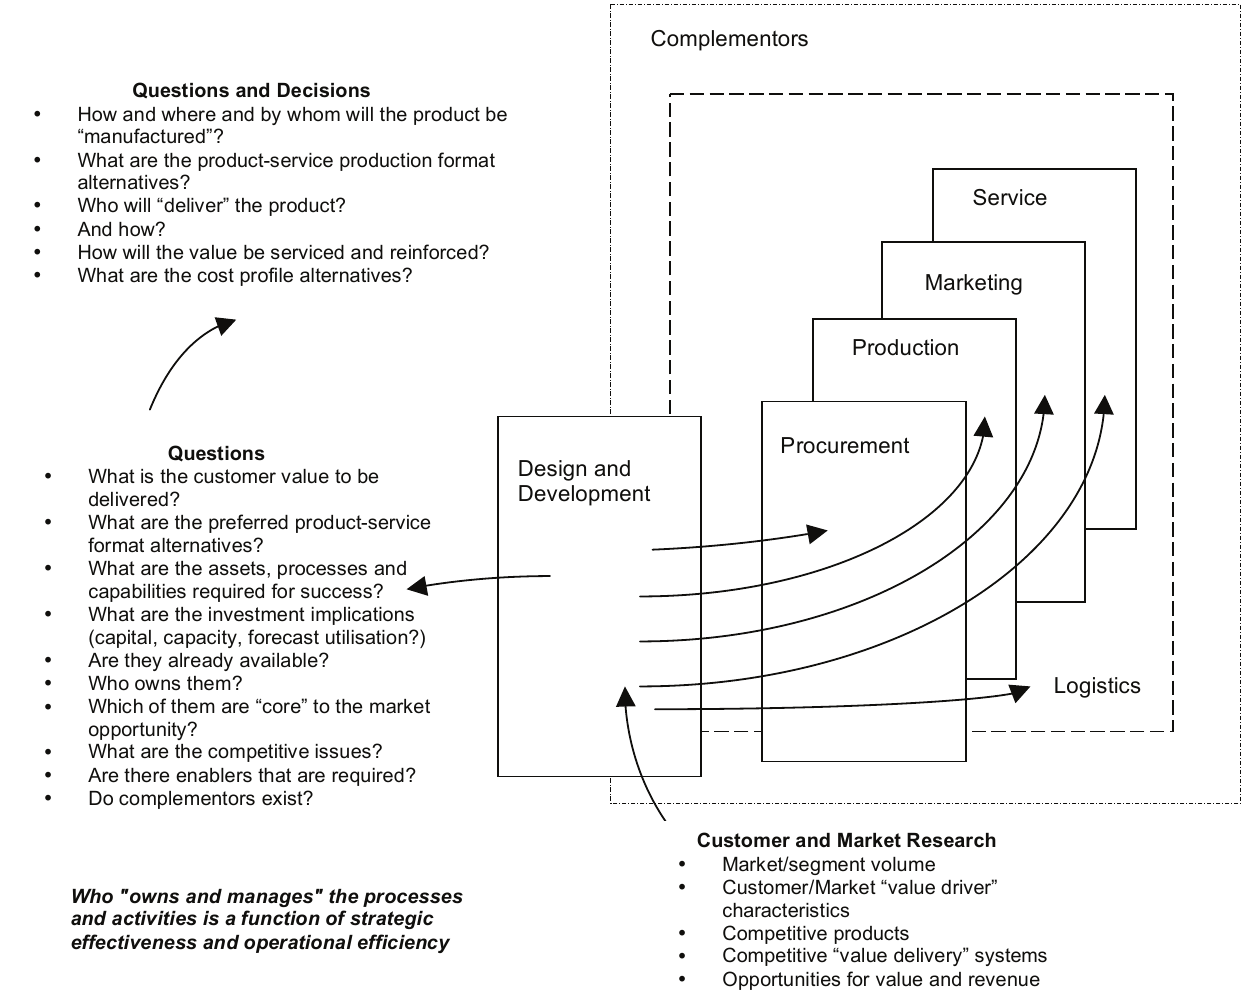
Figure 2: Effective value chain process management “thinks the problems through”